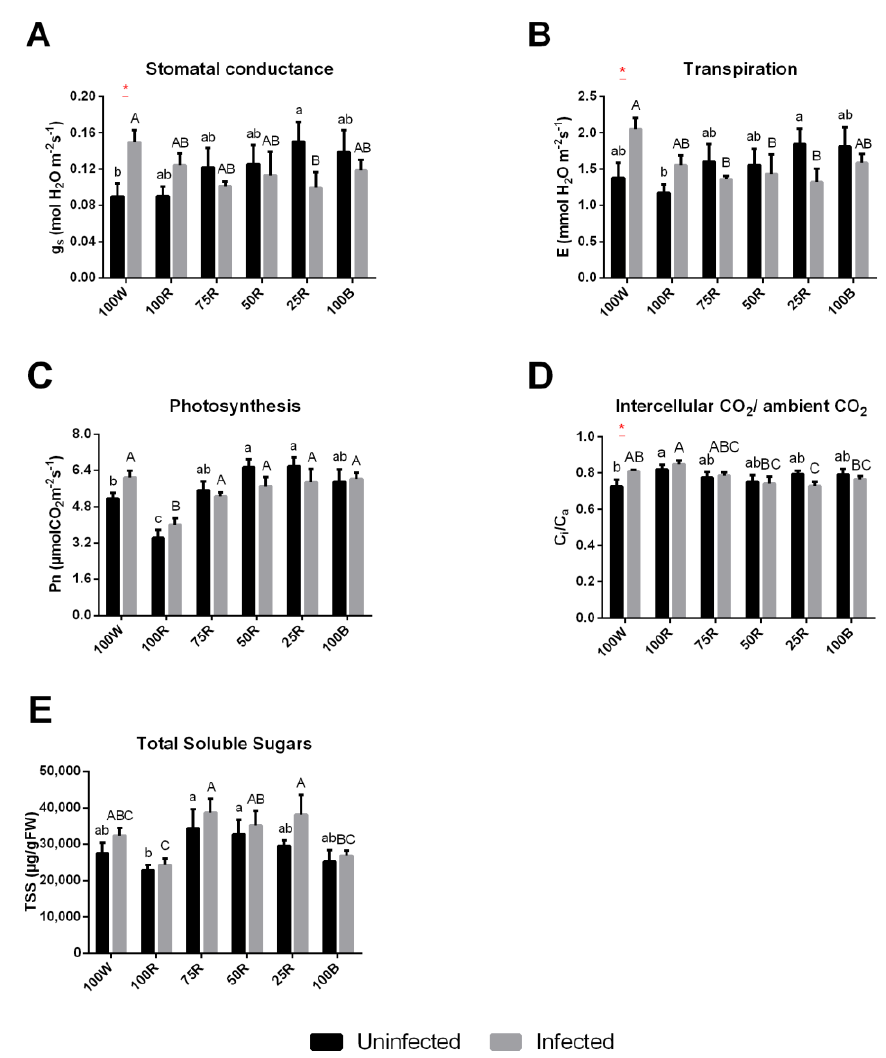
Figure 5. Light quality effect on leaf gas–exchange. Stomatal conductance, g s ( A ); transpiration rate, E ( B ); net photosynthetic rate, Pn ( C ); intercellular CO 2 /ambient CO 2 , C i /C a ( D ); total soluble sugars ( E ). The values are presented as the mean of at least 3 biological replicates ± SE. Lowercase letters represent multiple comparisons of uninfected groups, capital letters are multiple comparisons of infected groups and asterisks are comparisons of uninfected and infected groups in the same light treatment. Mean values with the same letter or without asterisk are not significantly different (Fisher LSD, p < 0.05).